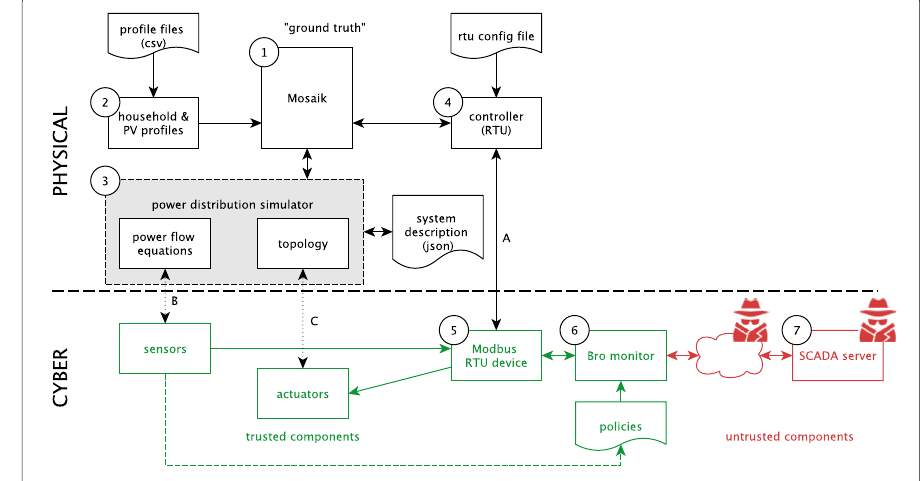
Fig. 3 Scheme of the testbed: the simulated part and the network components are shown. Figure 3 outlines the testbed. The simulated physical components are used as “ground truth” and depicted above the dashed line. The network components, including the source of malicious commands, are illustrated below the dashed line. The trusted parts are colored green and the untrusted parts red. The physical and the cyber parts are connected via a single physical connection (denoted A). The correspondence between the sensors and the actuators in the cyber part, to their values output by the power distribution simulator (power flow equations and topology), are indicated by dashed arrows, labeled B and C respectively. Traffic generated by the hacker reaches the Modbus RTU device only via the Bro monitor. The monitor then applies the safety and consistency checks before the command or sensor reading is put forward to the simulated physical part and included in the power distribution